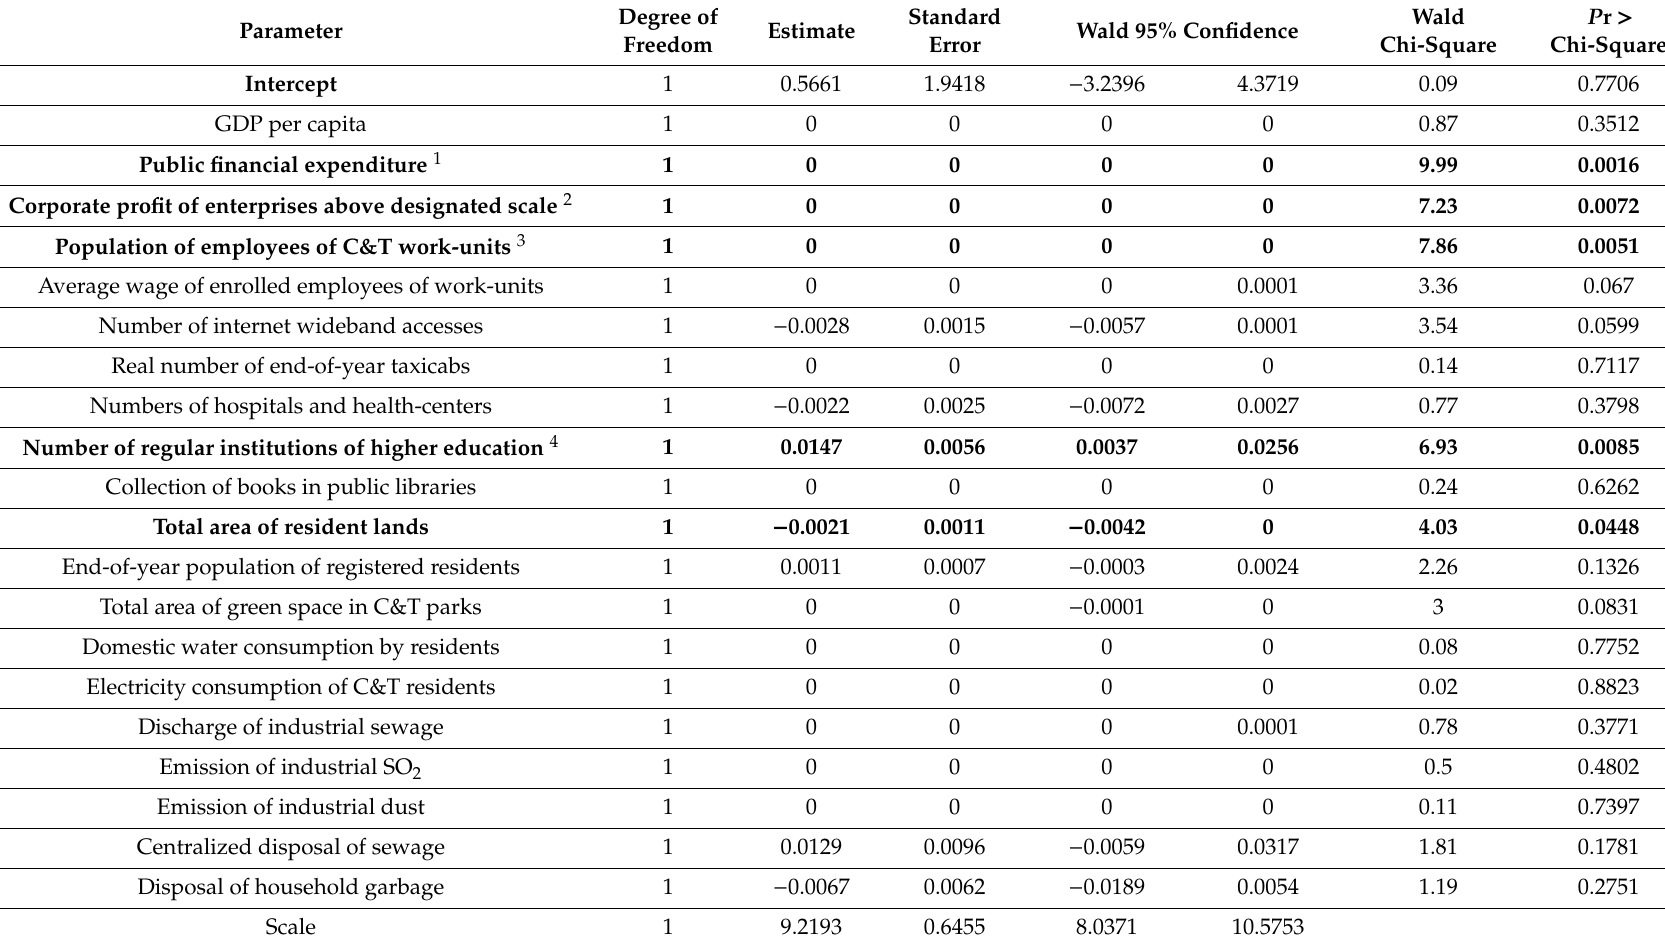
Table 6. Maximum likelihood estimation of multiple city variables on PRI expression scores of students from key universities of cities across mainland of